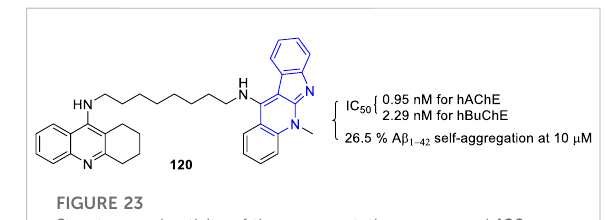
FIGURE 23 Structure and activity of the representative compound 120